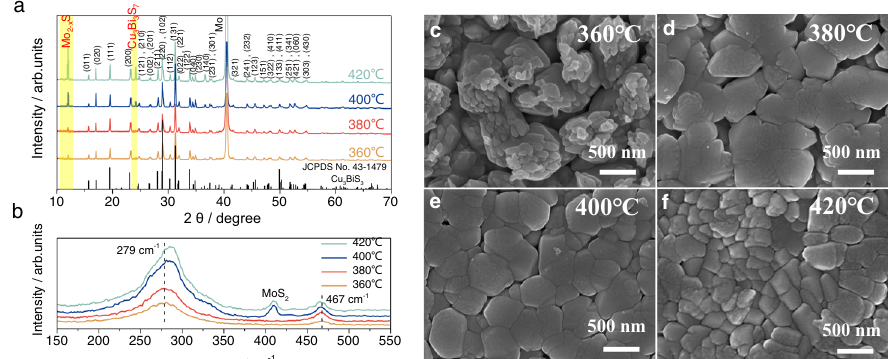
Fig. 1 Structural characterization of the Cu 3 BiS 3 thin fi lms. ( a ) XRD patterns and ( b ) Raman spectra of the Cu 3 BiS 3 fi lms sprayed at various substrate temperatures. surface SEM images of the Cu 3 BiS 3 fi lms sprayed at various substrate temperatures of ( c ) 360 °C, ( d ) 380 °C, ( e ) 400 °C and ( f ) 420 °C. Source data are provided as a Source Data